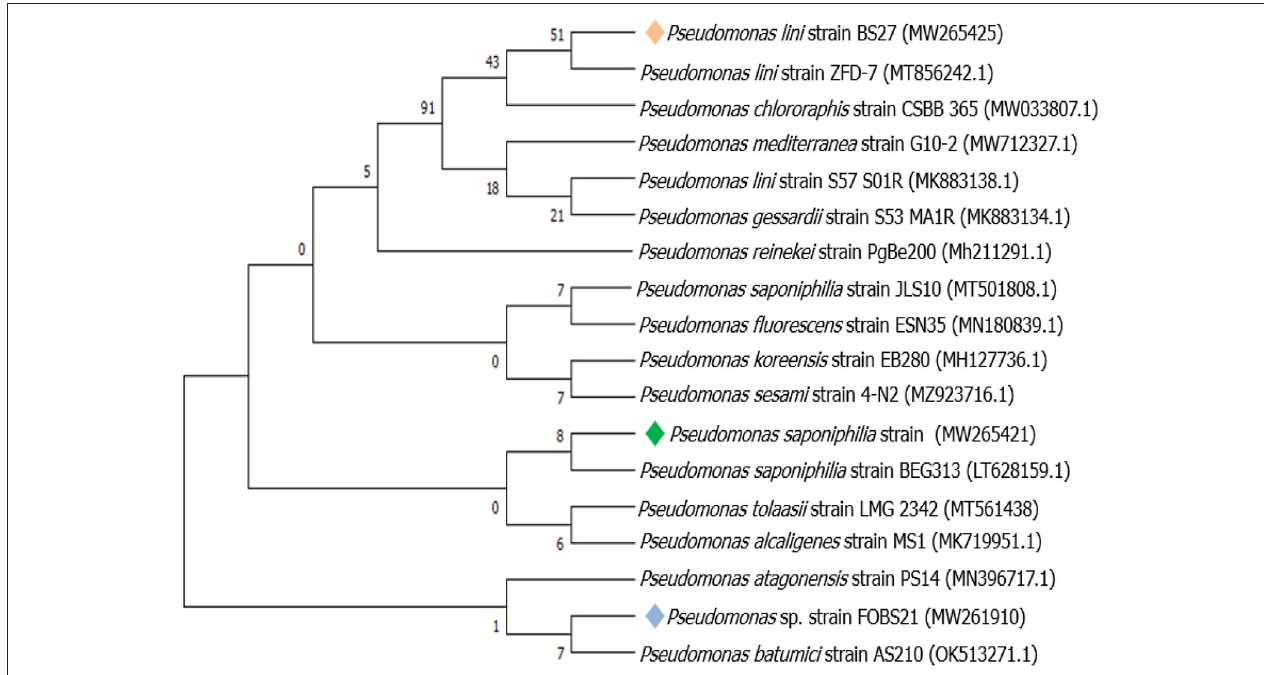
FIGURE 3 | Evolutionary relationships of taxa tree based on partial 16S rRNA sequences using maximum likelihood-based on the Tamura-Nei model showing relationships between the endophytic Pseudomonas species and its closely related strains from NCBI